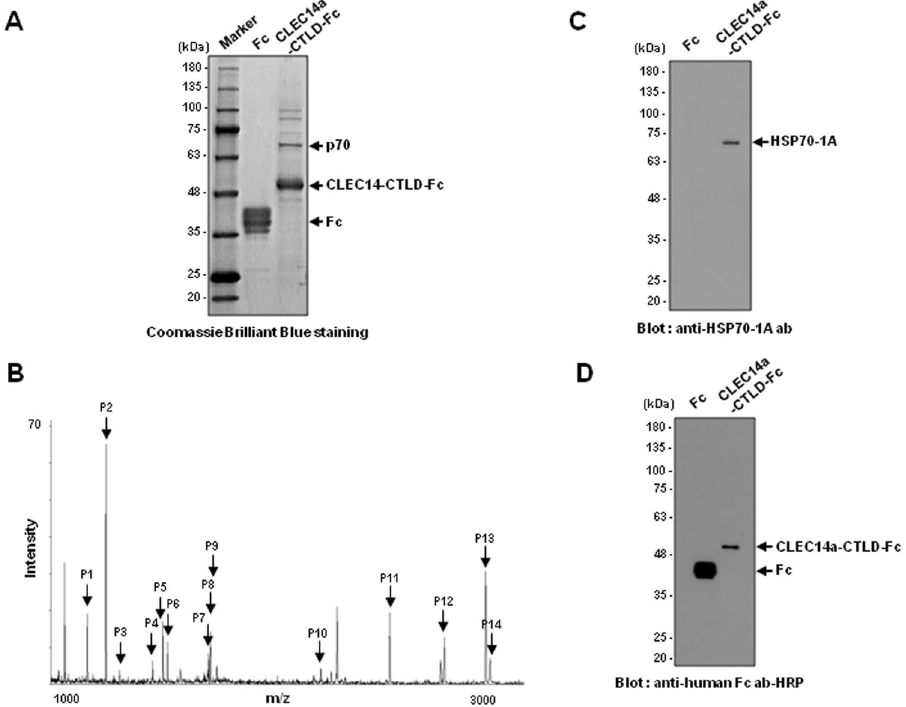
Figure 1. Identification of a 70-kDa CLEC14a-CTLD-binding protein as HSP70-1A. ( A ) HEK293F cells were transfected with vectors encoding CLEC14a-CTLD-Fc or Fc, and after 7 d, the fusion proteins were precipitated from the culture media using protein A Sepharose. The precipitated proteins were separated by SDS-PAGE and visualized with Coomassie brilliant blue staining. The CLEC14a-binding protein with a molecular mass of 70 kDa (p70) is designated by an arrow. Marker: size marker. ( B ) p70 was digested with trypsin, and the resulting peptide mixture was analyzed by matrix-assisted laser desorption ionization/time-of-flight mass spectrometry (MALDI-TOF MS). The arrows (P1–P14) indicate the measured tryptic peaks of p70 whose calculated molecular masses match those of HSP70-1A within 50 ppm. Equal amounts of co-precipitates were separated and analyzed by immunoblotting with antibodies directed against HSP70-1A ( C ) and human Fc ( D ). The lane order is the same as that in ( A ). The results shown are representative of two separate